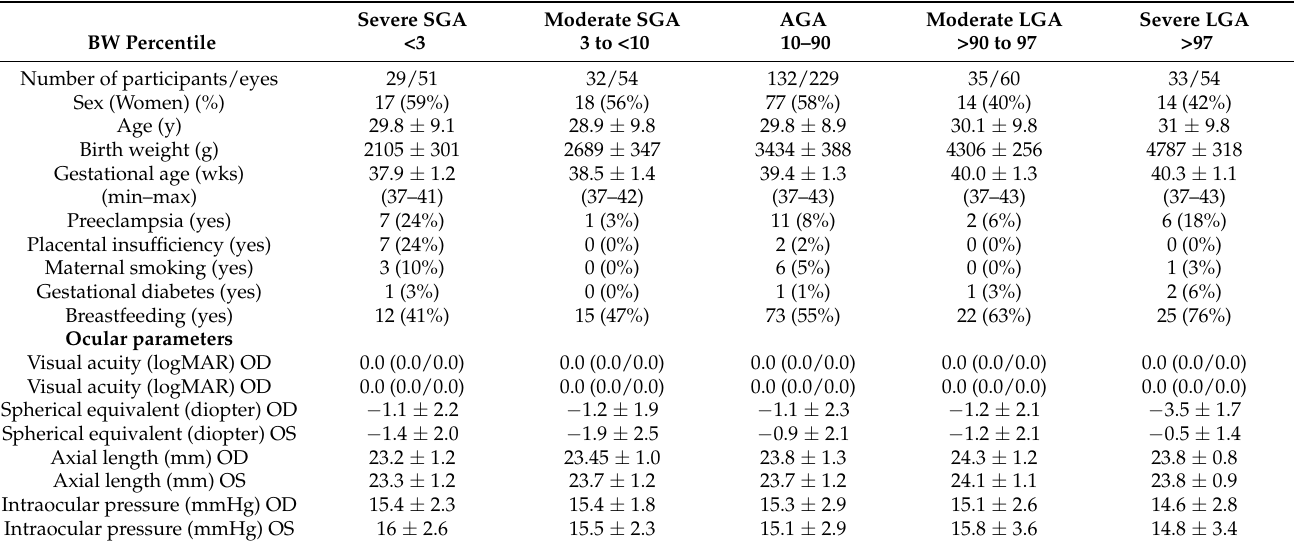
Table 1. Characteristics of the study sample ( n = 261) of individuals born at term stratified by birth